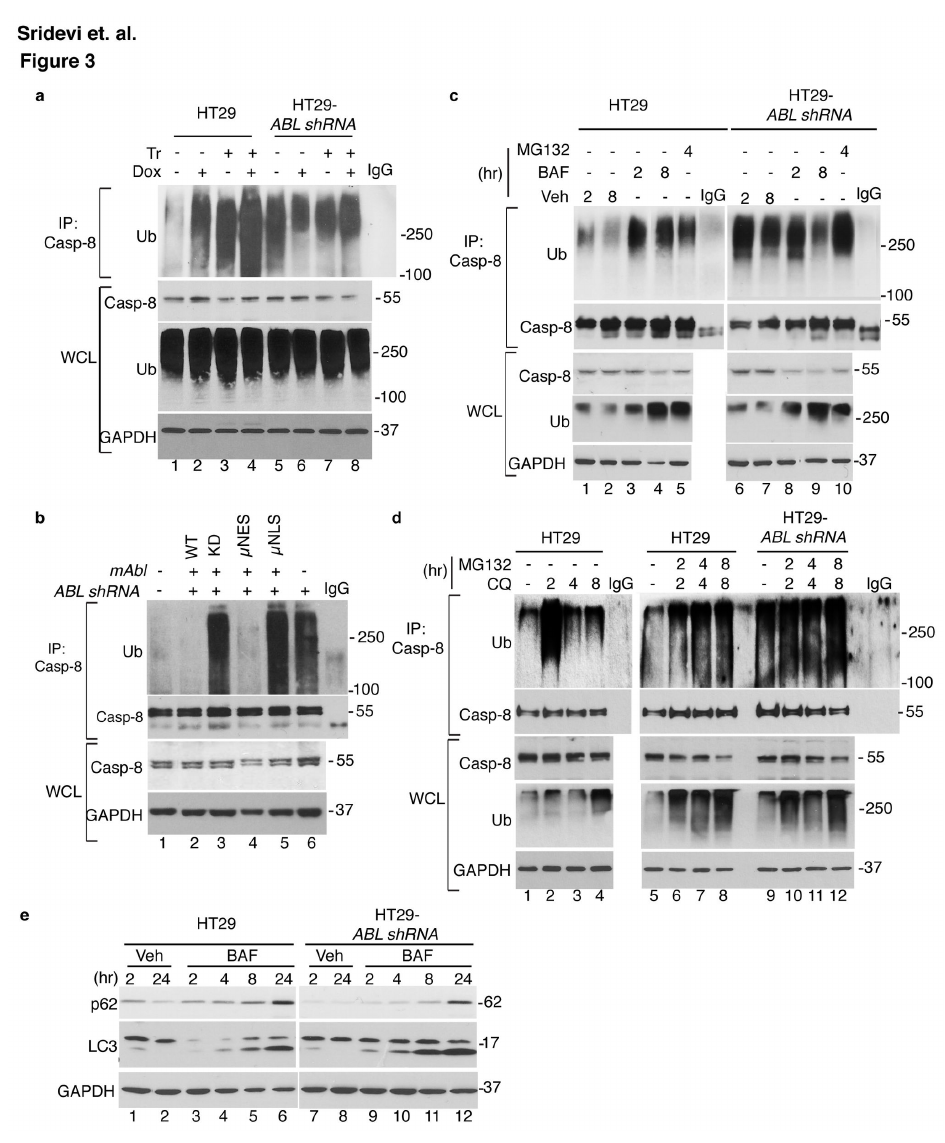
Figure 3. Effects of ABL-knockdown, mAbl-reconstitution and lysosomal inhibitors on ubiquitinated caspase-8. a. Inducible vs. constitutive levels of Ub-C8 in parental vs. ABL-knockdown HT29 cells. Following treatment with 2.0 µg/ml Dox